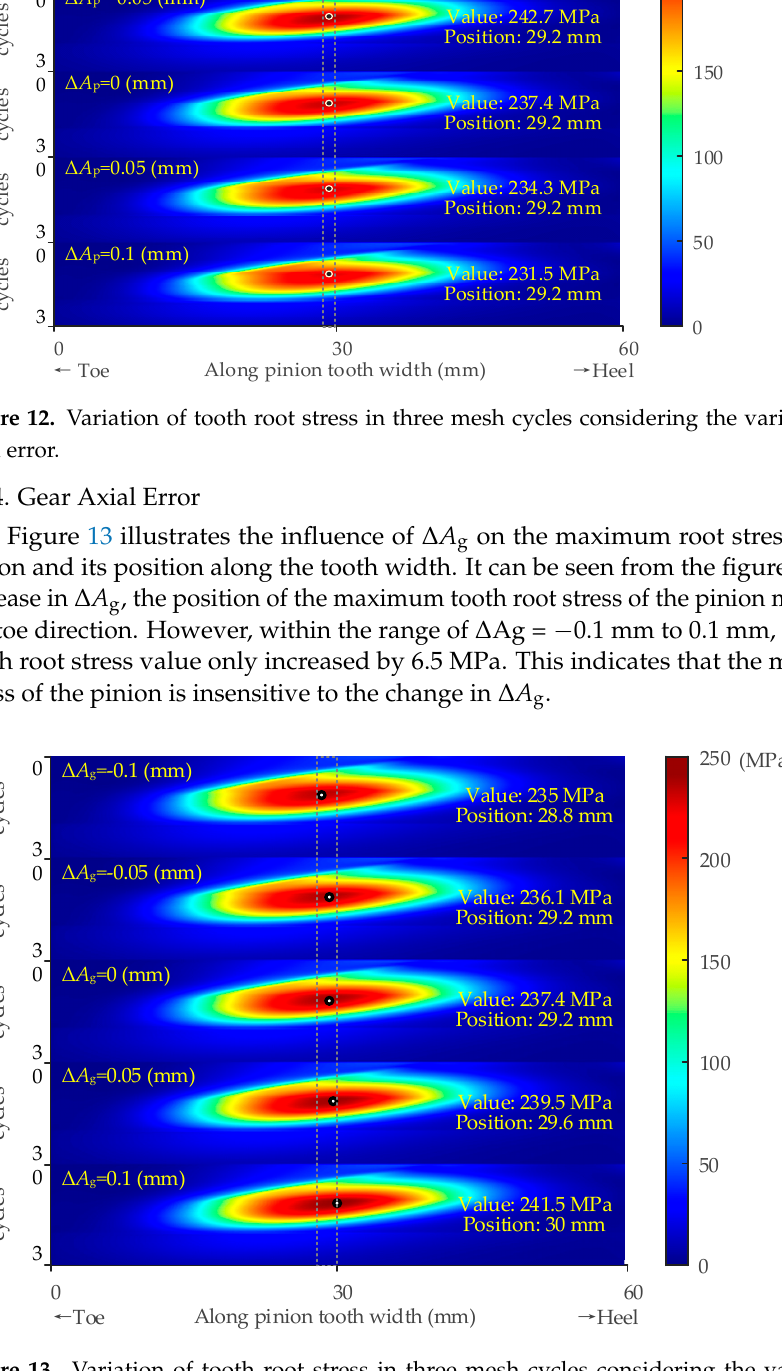
Figure 13. Variation of tooth root stress in three mesh cycles considering the variation of gear axial error.